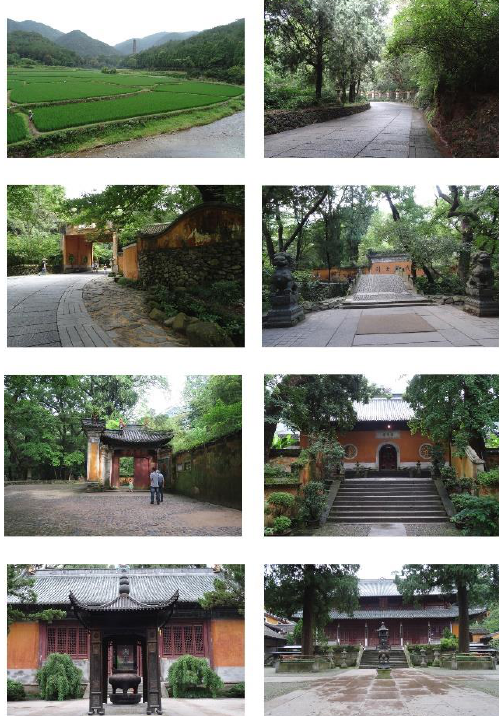
Figure 19. Worship itinerary of Guoqing Si. Religions 2021 , 12 , x FOR PEER REVIEW